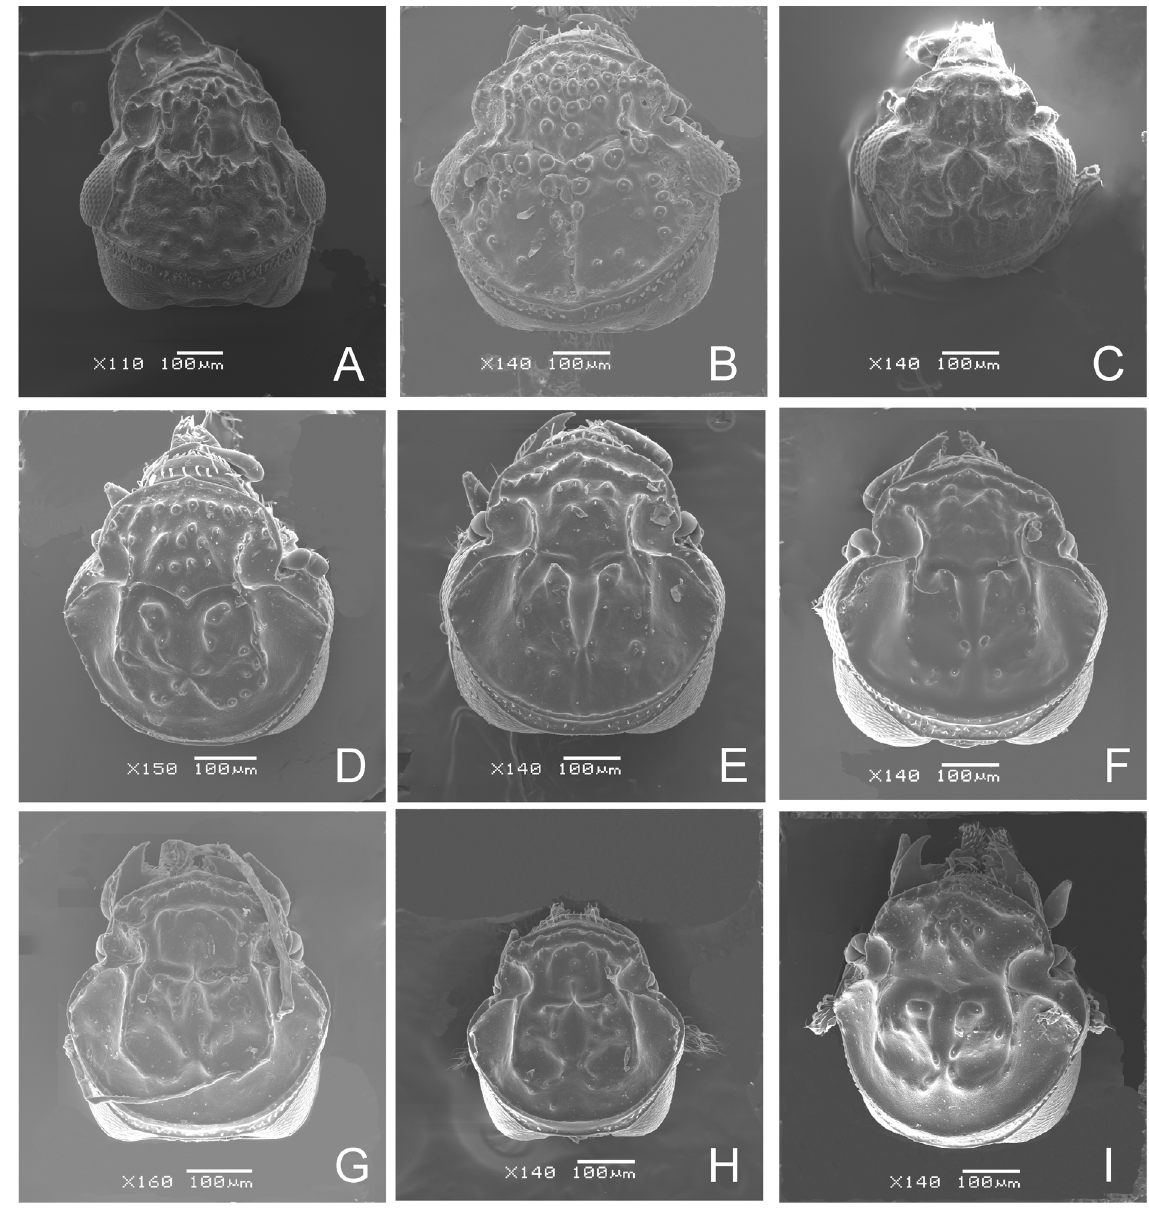
Fig. 6. Head of Georissus spp. A . G . ( G .) canalifer Sharp, 1888. B . G . ( G .) babai Satô, 1970. C . G . ( Ni .) granulosus Satô, 1972. D . G . ( Ne .) japonicus Satô, 1972. E–F . G . ( Ne .) kurosawai Nakane, 1963 from Hokkaido (E) and Nagano (F). G–H . G . ( Ne .) takahashii sp. nov. from Kochi (G) and Okinawa (H). I . G . ( Ne .) satoi sp.